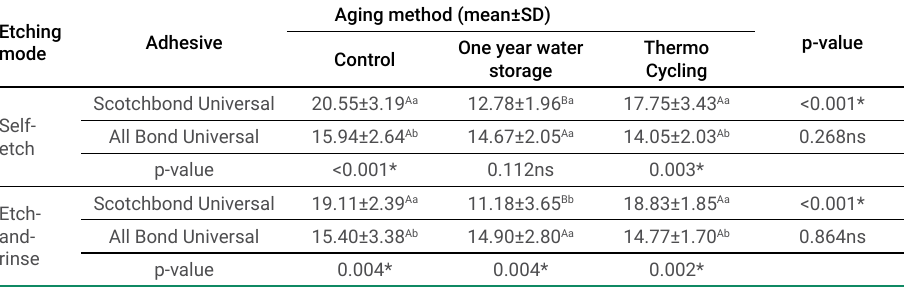
Table 2. Mean ± standard deviation (SD) values of micro-shear bond strength (MPa) for the effect of different aging methods, adhesives and etching modes. Etching